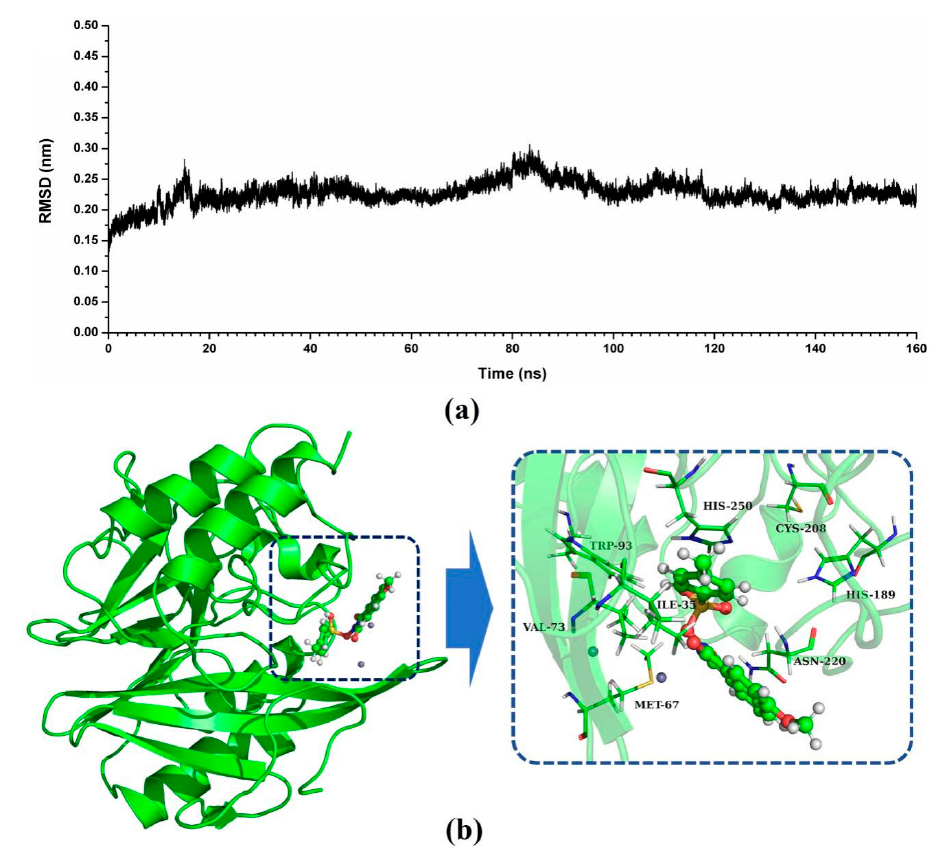
Figure 2. Identification of the binding sites of ZINC05683641 with NDM-1. ( a ) The RMSD values of NDM-1 with ZINC05683641 complex via simulation times; ( b ) The potential binding mode of ZINC05683641with NDM-1 based on MD